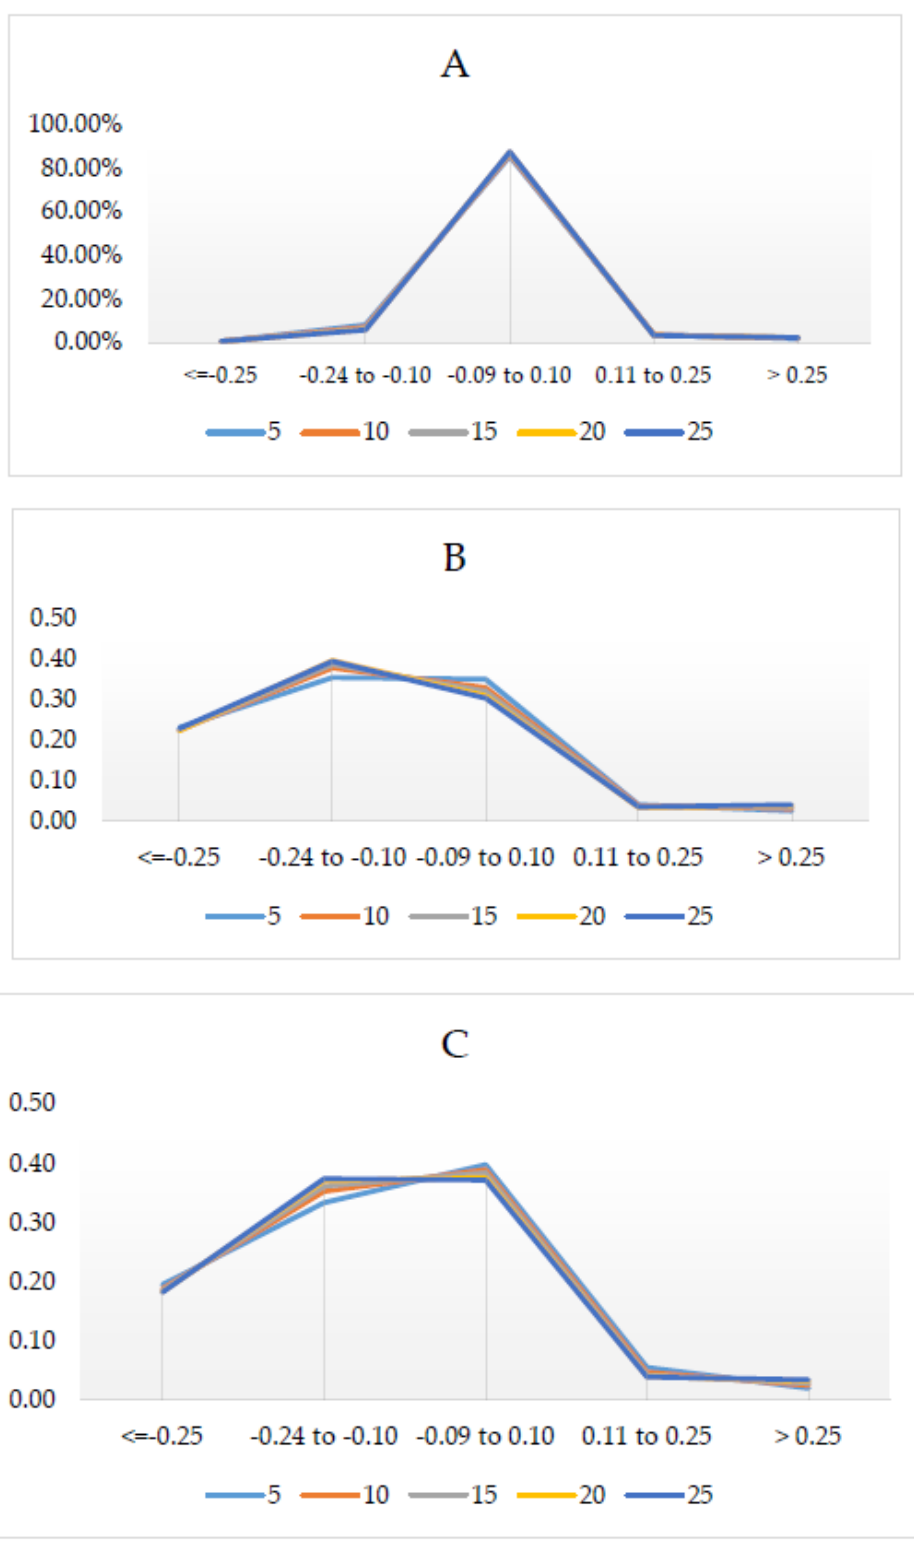
Figure 6. The percentage of area ( Y -axis) for elevation difference (in meters) ( x -axis) for each tessellation (5 m 2 through 25 m 2 ) for ( A ) comparison between the Quanergy and Velodyne sensors; ( B ) comparison of Velodyne with the QL2 data, and ( C ) comparison of Quanergy with the QL2 data.